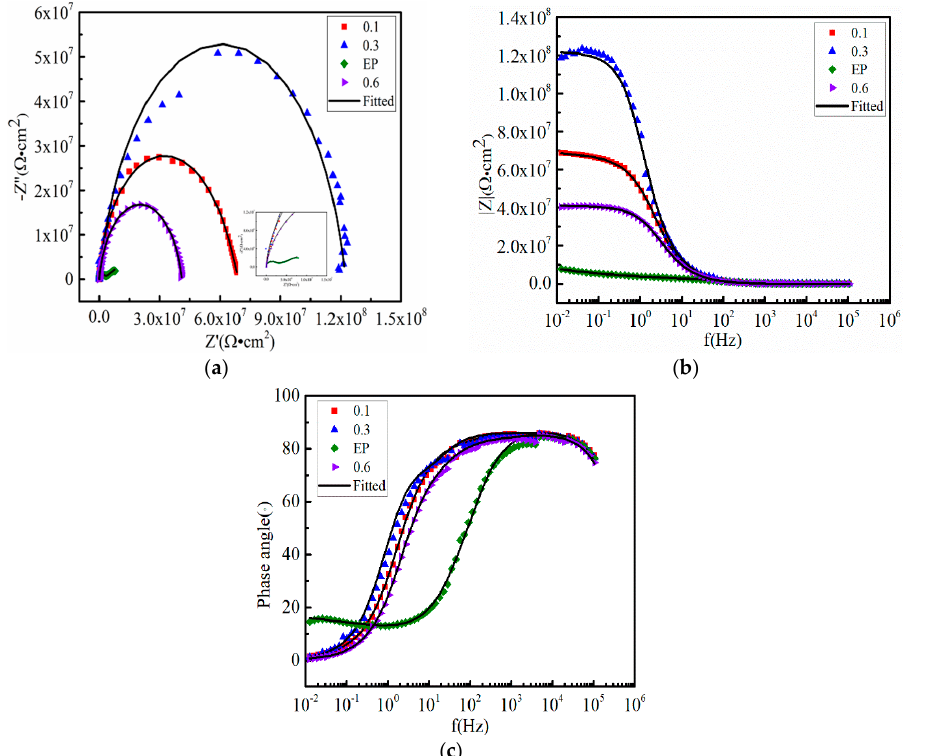
Figure 7. Nyquist and Bode diagrams of composite coatings coated with different ration of TPG ( a – c ) after immersion for 400 h in 3.5% NaCl solution.